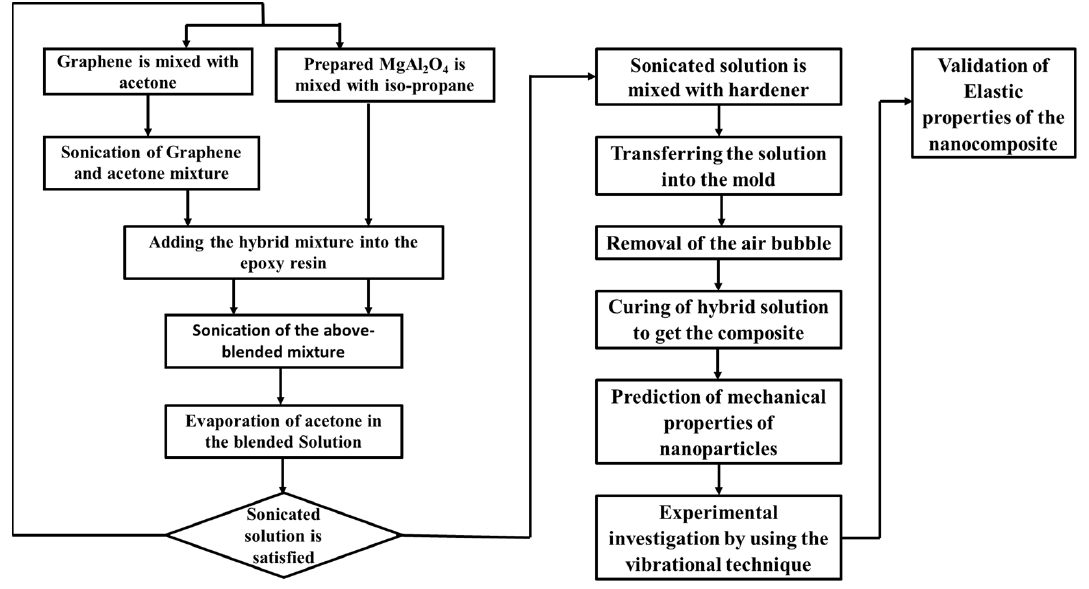
Figure 1. Flow Chart for preparation of Epoxy/Graphene